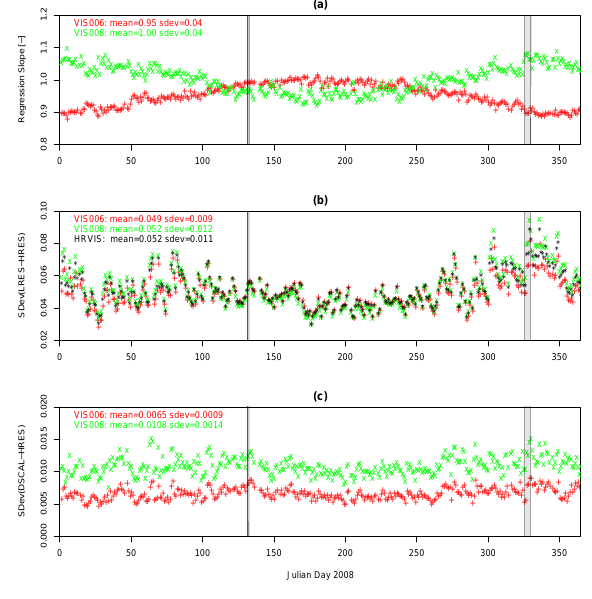
Fig. 5. Annual time series of (a) the linear regression slopes found to link variations in the HRV channel to unresolved variations in the 0.6 (VIS006, red) and 0.8µm (VIS008, green) channel; (b) the es- timated standard deviation of the difference between 1 × 1 (HRES) and 3 × 3km 2 (LRES) images for the three spectral channels; and of (c) the estimated residual standard deviation of the proposed down- scaling algorithm. Periods when Meteosat-8 replaced Meteosat-9 as operational satellite due to spacecraft anomalies have been shaded in